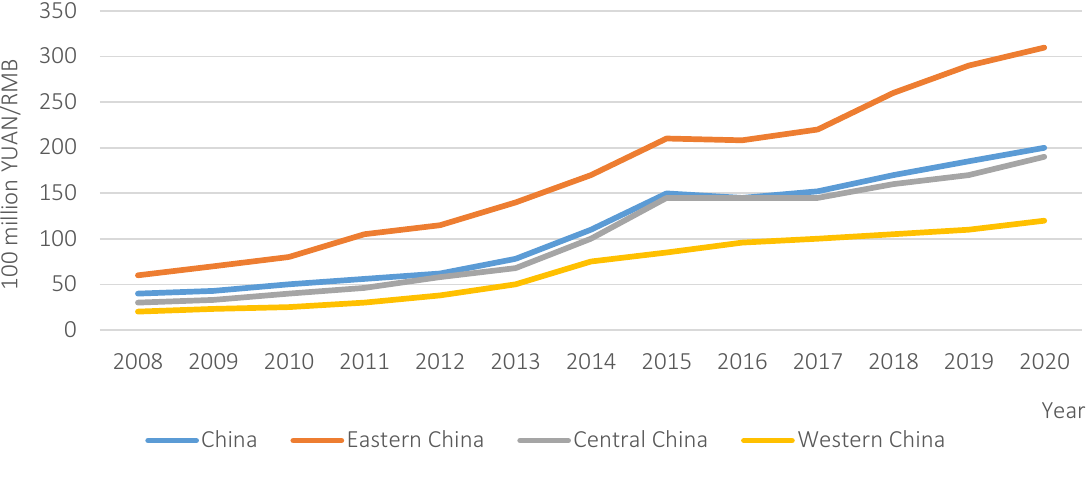
Figure 1. Average GFHE scale of each area in China by province (100 million yuan/RMB)